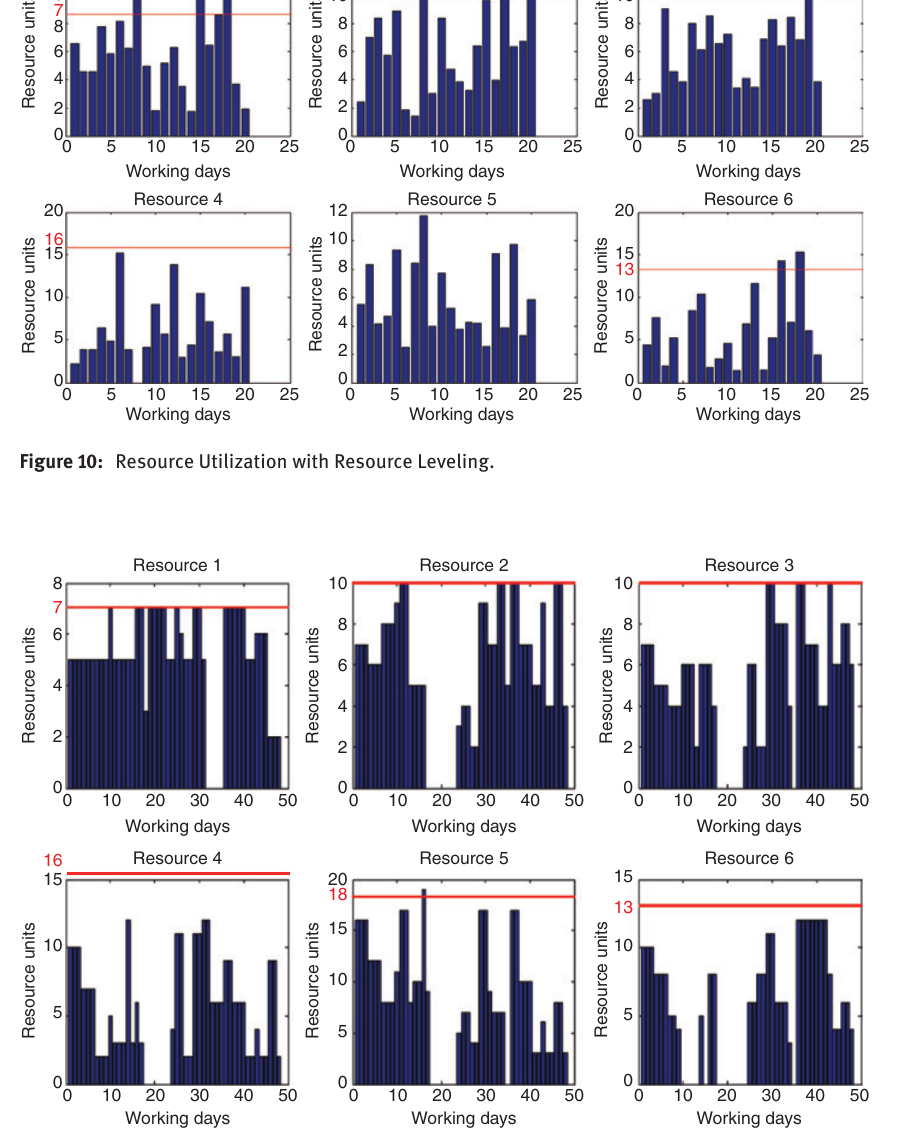
Figure 12 represents histograms of each resource after optimization with MOPSO. Resource distribution is uniform among project activities. R2, R3, and R6 are overallocated; however, the overallocation is very small as compared to the project plan in Figure 10. Moreover, only two resources sit idle during working days, which is comparatively smaller than that in the project plan with resource leveling in Figure 10. By using MOGA, four resources are overallocated, which can be seen in Figure 12; however, while using MOPSO, only two resources (R1 and R3) are overallocated.